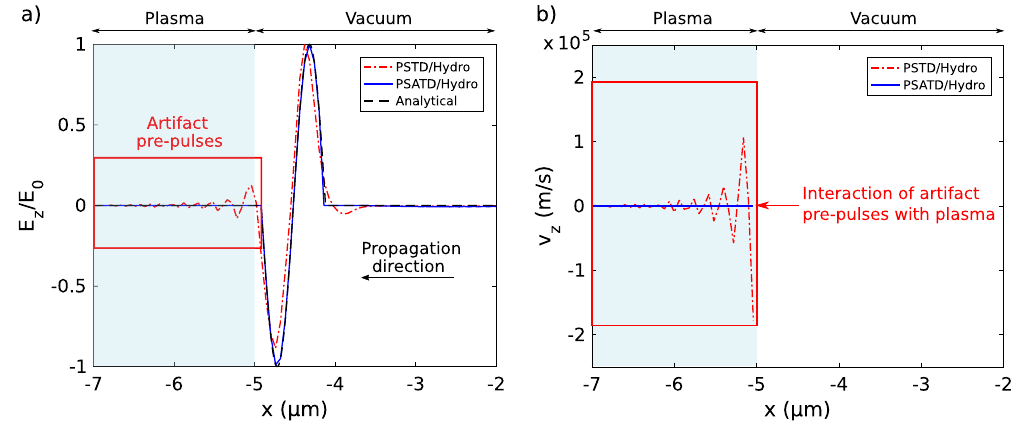
Figure 7. ( a ) Single-cycle pulse propagation with PSTD/Hydro solver (red dashed-dotted line) and with PSATD/Hydro solver (solid blue line). The laser pulse interacts in normal incidence on a plasma ramp starting at x ≤ − 5 µ m as shown in light blue on the figure. The PSATD/Hydro curve is superimposed on the analytical solution shown as a black dashed line. We observe artifact pre-pulses generated by numerical dispersion of PSTD in the plasma region. ( b ) Velocity component v z of electron fluid at the same